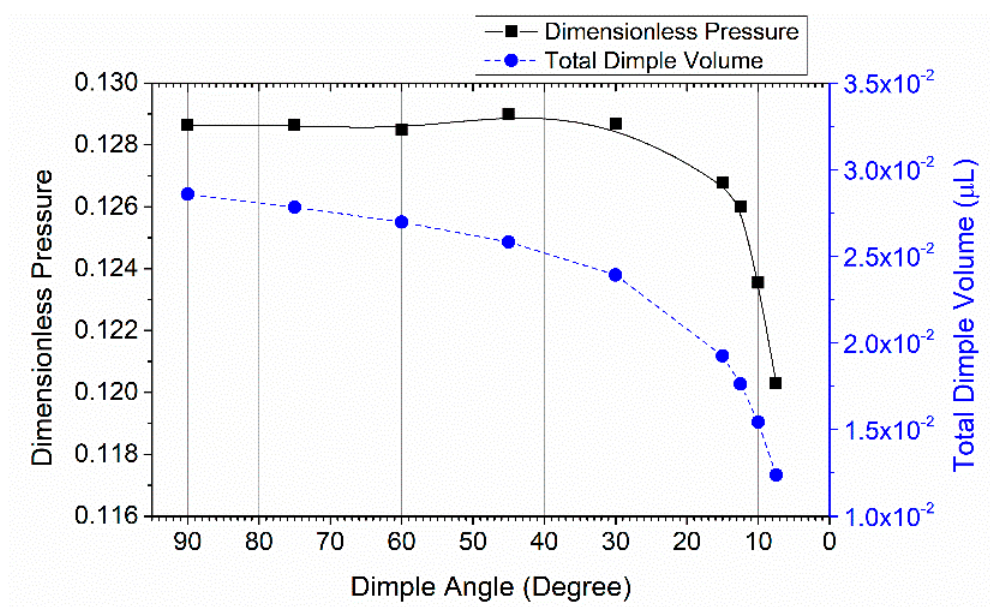
Figure 11. Average pressure on the top surface of the model and the total volume of dimples as the dimple surface angle changes.